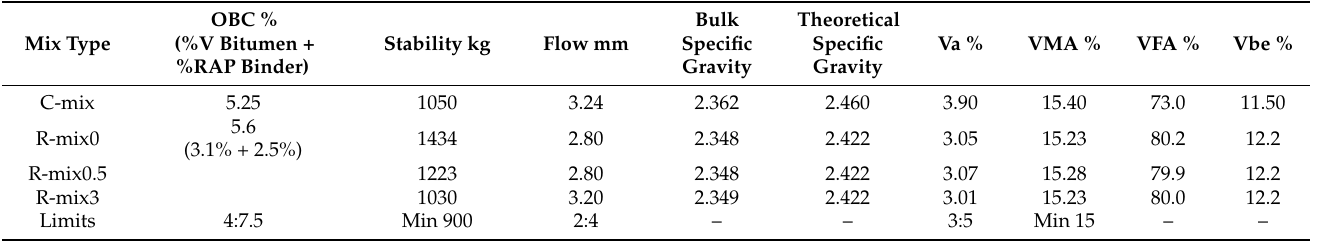
Table 6. Summary of Marshall parameters and volumetric properties of the investigated mixes.